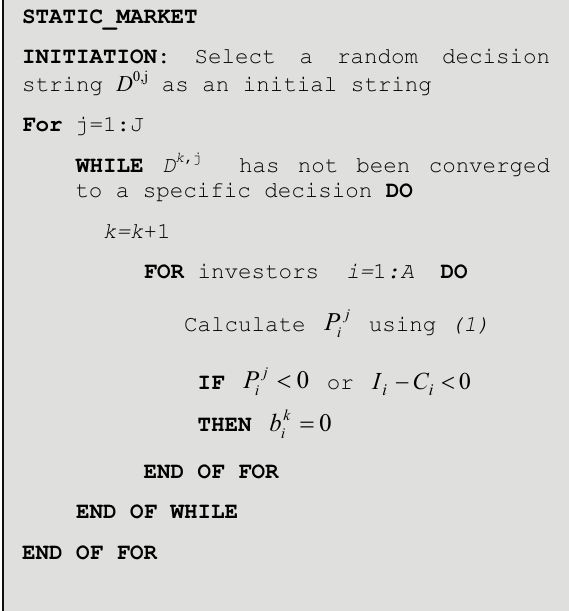
Fig. 1. Negotiation algorithm for decision making in static markets based on artificial capital